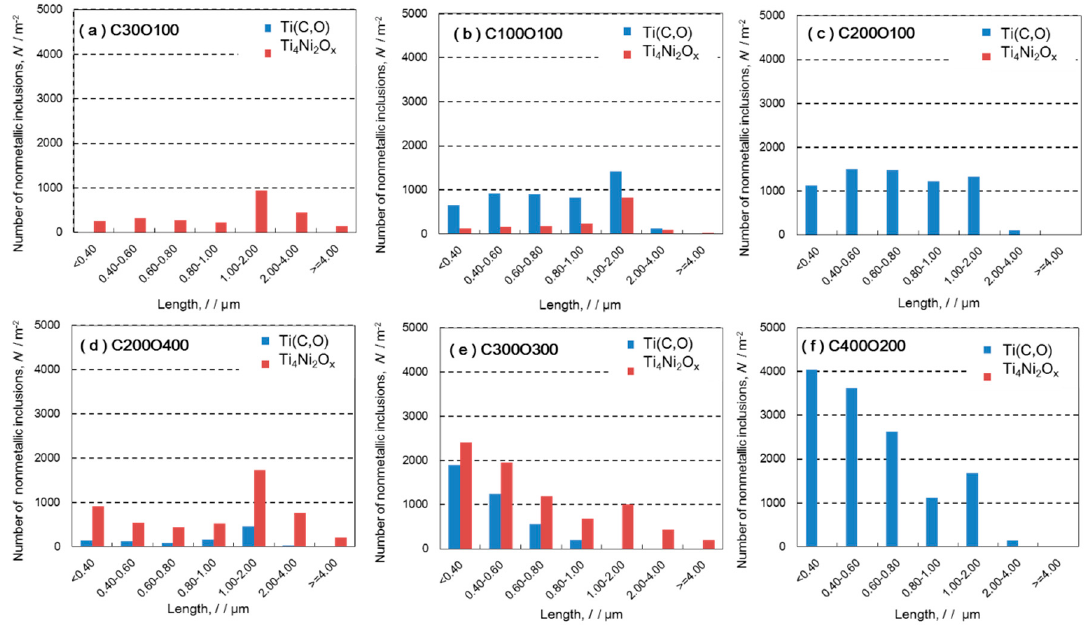
Figure 4. Analysis of nonmetallic inclusions by phase and distribution of length parallel to the wire drawing direction. ( a ) C30O100, ( b ) C100O100, ( c ) C200O100, ( d ) C200O400, ( e ) C300O300, and ( f ) C400O200.